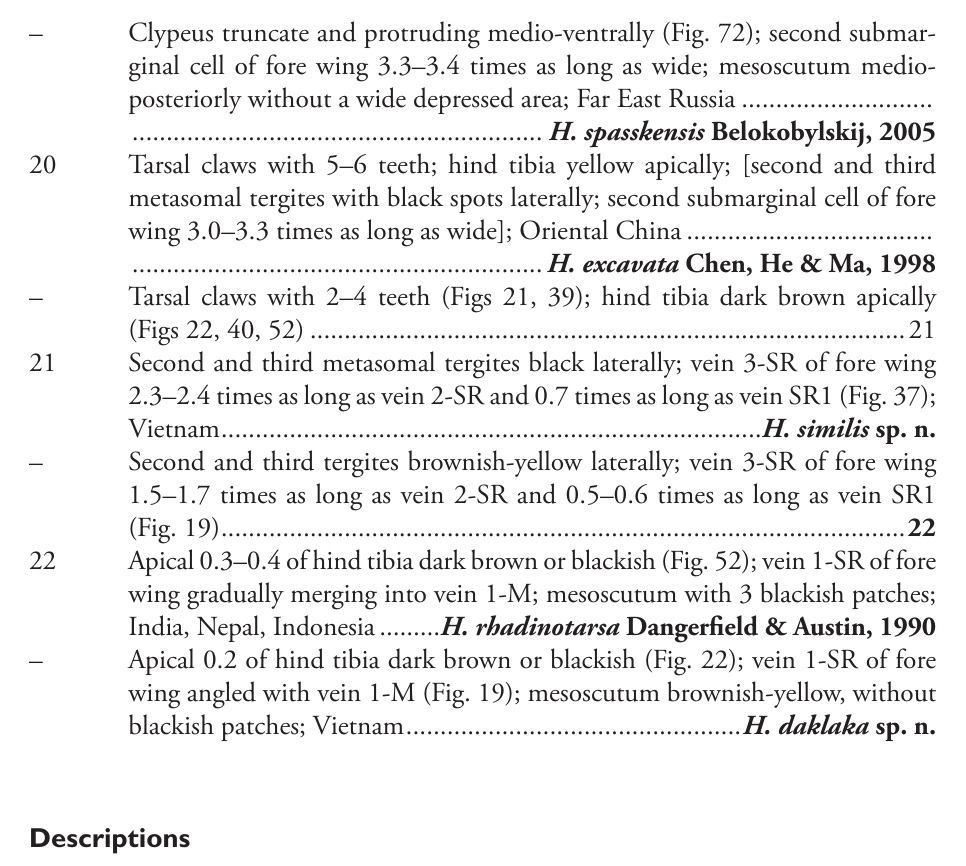
Type material. Holotype, female (IEBR), “Card.059”, “[S Vietnam:] Dak Lak, Easo, coffee farm, MT, 108 ° 37’E, 02.vii.2008, Ngo Hien”. Diagnosis. The new species is close to H . rhadinotarsa Dangerfield & Austin, but differs by having epistomal suture indistinctly developed, with the rugosities of the face and the punctures of the clypeus distinct (suture distinct and face and clypeus finely punctate in H . rhadinotarsa ); the occiput deeply concave (moderately concave in H . rhadinotarsa ); the hind tarsal segments (excerpt basitarsus) 0.6 times as long as hind basitarsus (0.8 times in H . rhadinotarsa ) and the hind tarsal claws with 5 teeth (2–4 teeth in H . rhadinotarsa ). Differs from H . excavata Chen, He & Ma by having the transverse diameter of the eye in dorsal view 1.3 times as long as the temple (0.9 times in H . excavata ), POL 1.5 times OD (1.3 times in H . excavata ) and the scutellar sulcus with 5 cross-carinae (3 cross-carinae in H . excavata